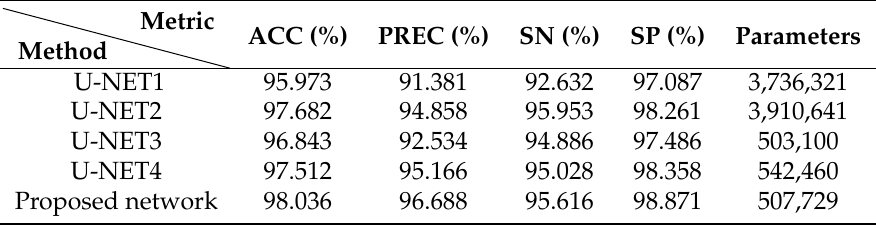
Table 2. Metrics Comparison of Different Shadow Detection